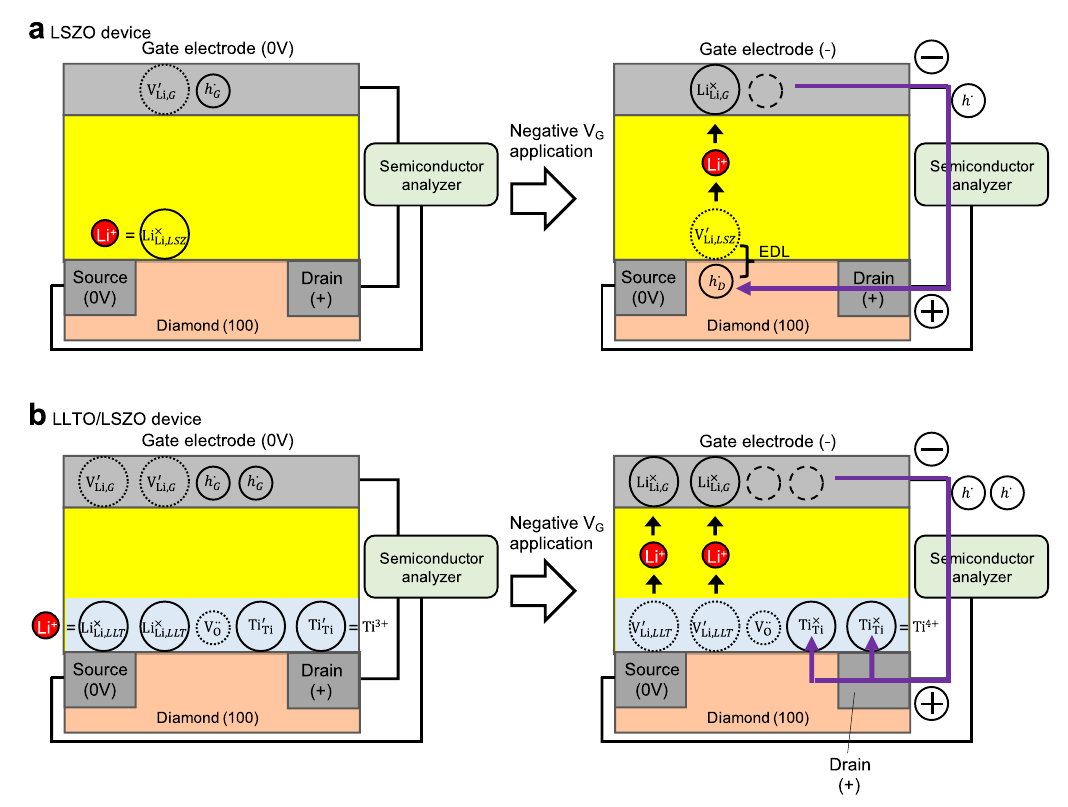
Fig. 3 Interpretation of the device characteristics based on defect chemistry. Illustrations of EDL formation in LSZO device a and the suppression in LLTO/LSZO device b under the negative V G applied condition [the polarity at all terminals is the same as shown in Figs. 1a and 2c]. Li + in the electrolyte and h (cid:2) in the lead wire are shown only as indicators of the polarity of the electric